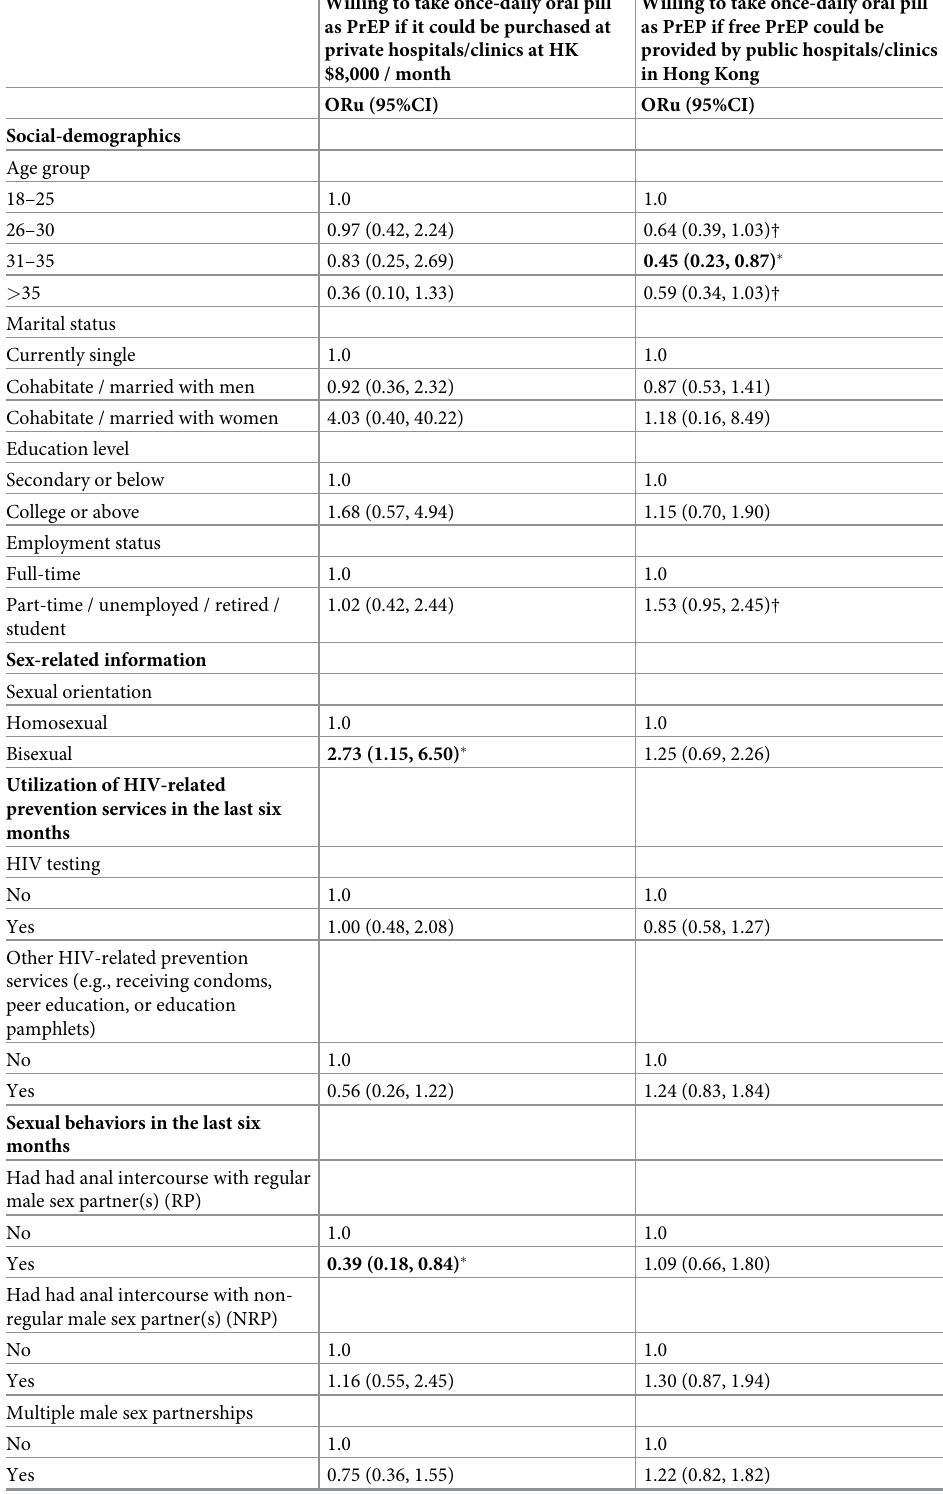
Table 3. Background variables associated with two measures of willingness to use daily oral PrEP (n =